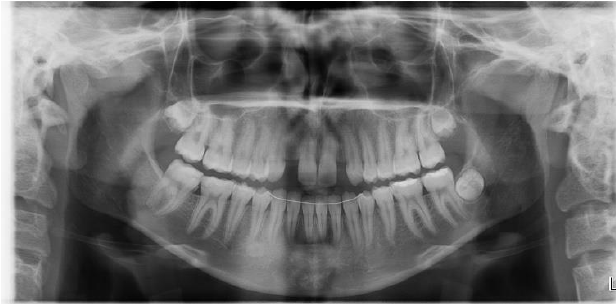
Fig. 3. Cone Beam Computed Tomography images showing complete separation of the pulp chambers of second mandibular molar and the supernumerary